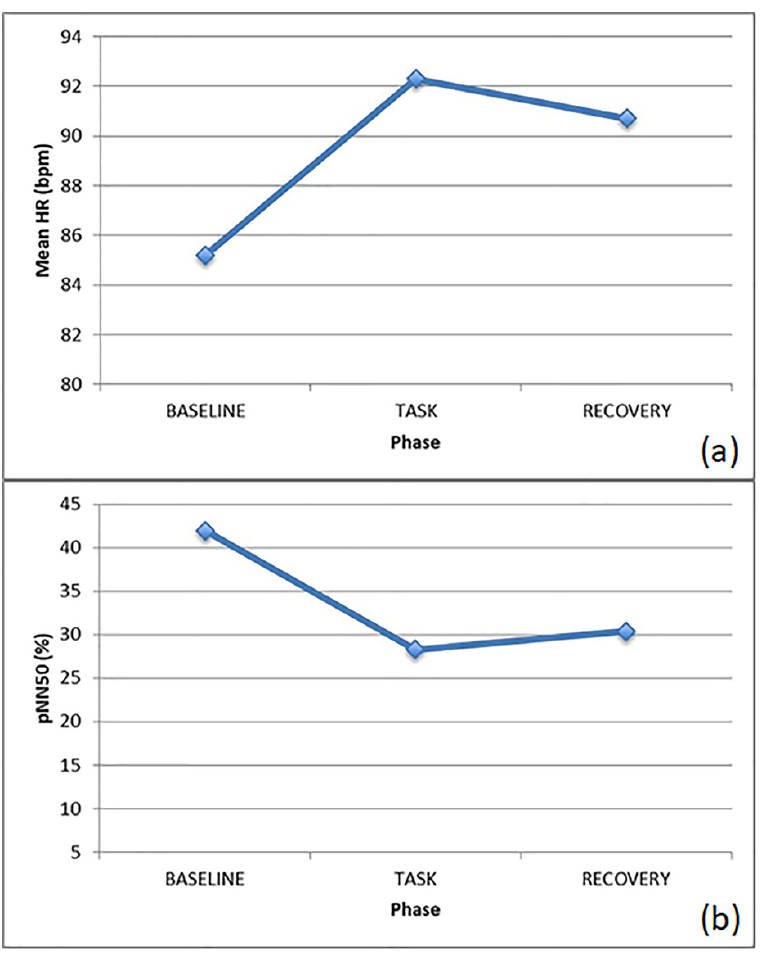
Figure 5. ECG features for J. during the various phases of the action on the represented: ( a ) HR, ( b ) pNN50.